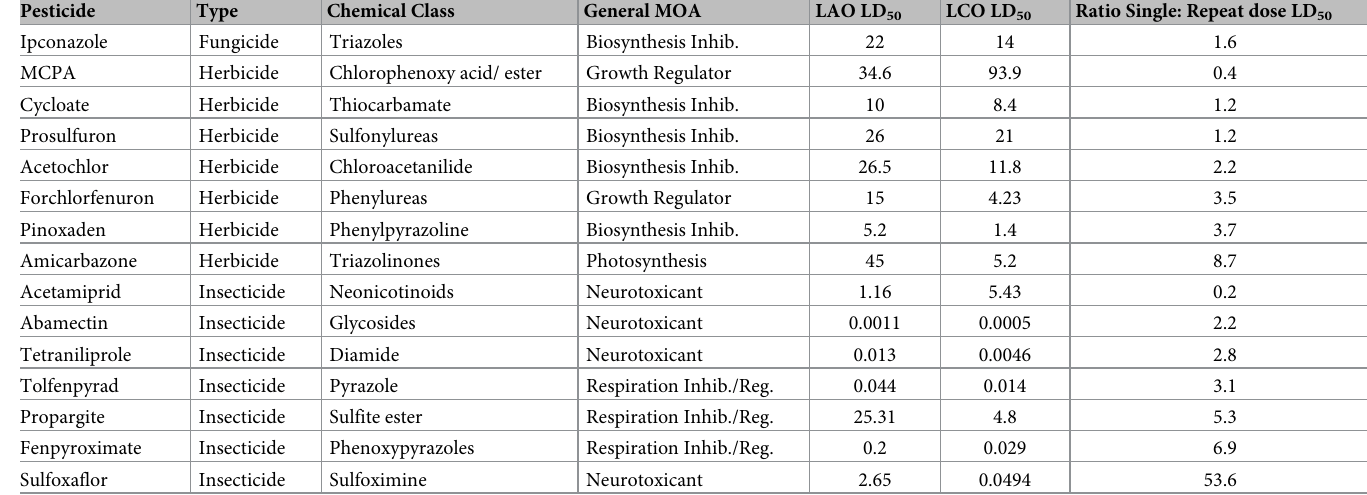
Table 2. Comparison of larval honey bee ( Apis mellifera ) acute (LAO; single dose; OECD TG 237) and chronic (LCO; repeat dose; OECD GD 239) LD 50 values (N = 15) expressed in terms of μ g ai larva -1 day -1 .